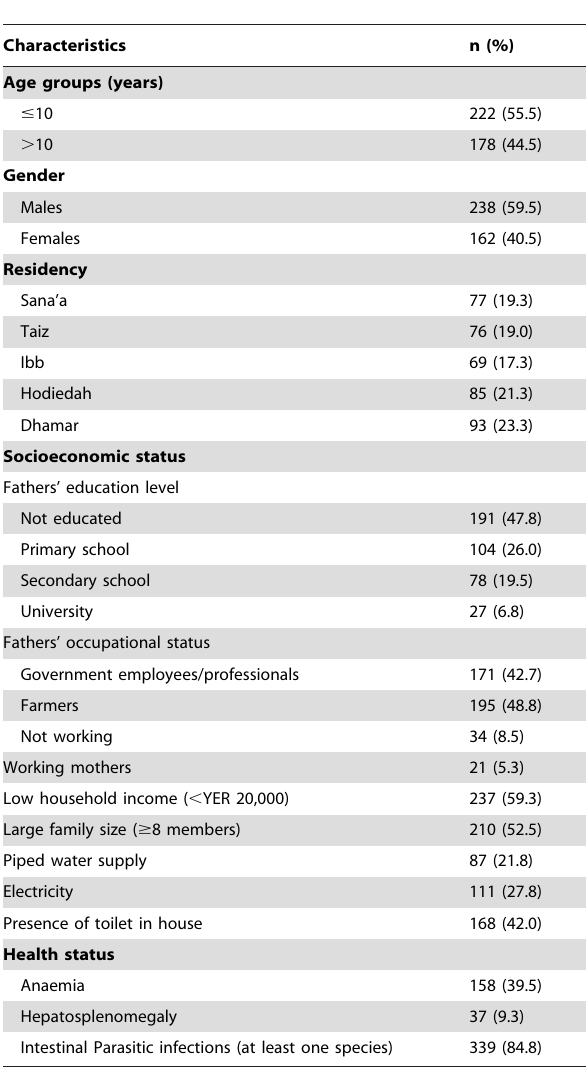
Table 1. General characteristics of Yemeni children who participated in this study (n= 400).